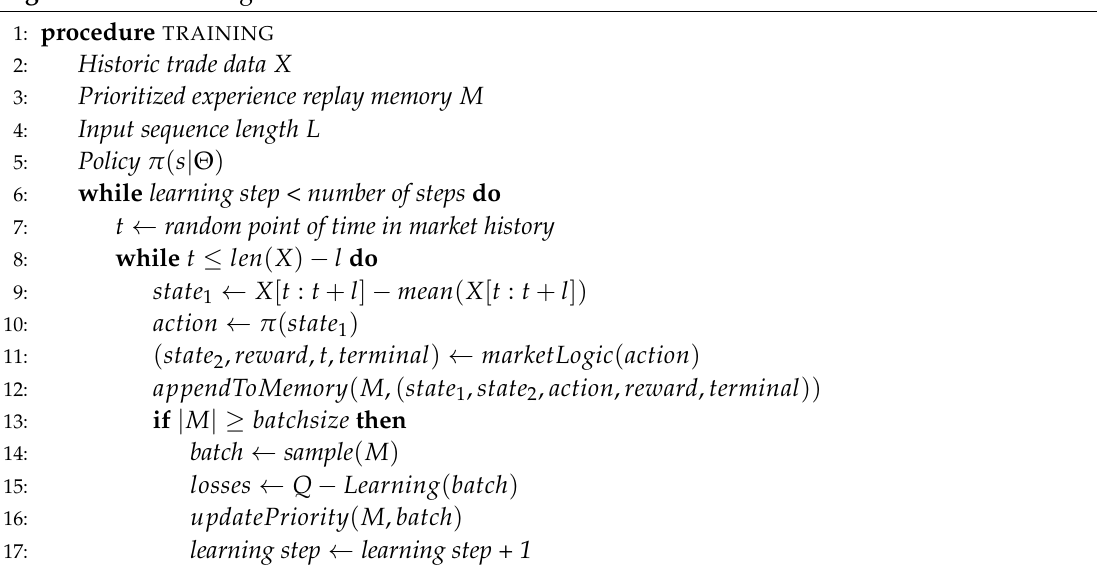
Algorithm A1 Training in market